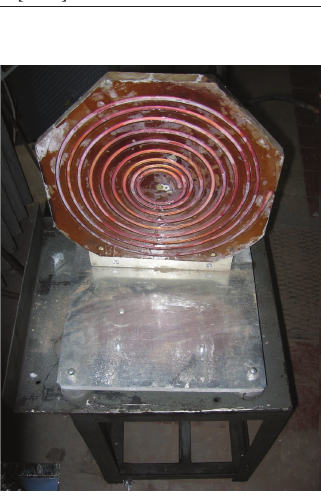
Figure 7: Half of the concrete mould with metal elements.